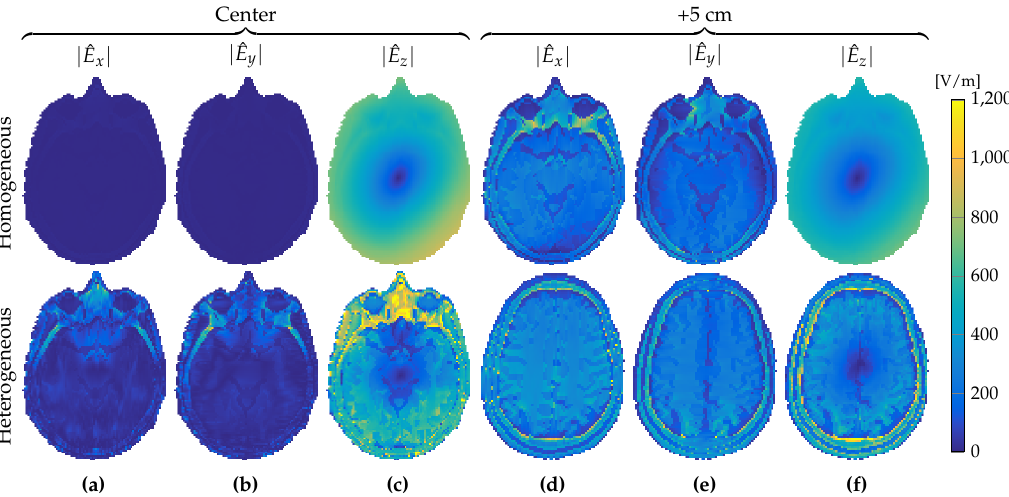
Figure 3. Magnitude of electric-field-strength components. x , y , and z components at ( a – c ) the transversal midplane, and ( d – f ) the slice 5 cm higher, respectively. Top and bottom row show fields in the case of a longitudinal homogeneous and heterogeneous object,